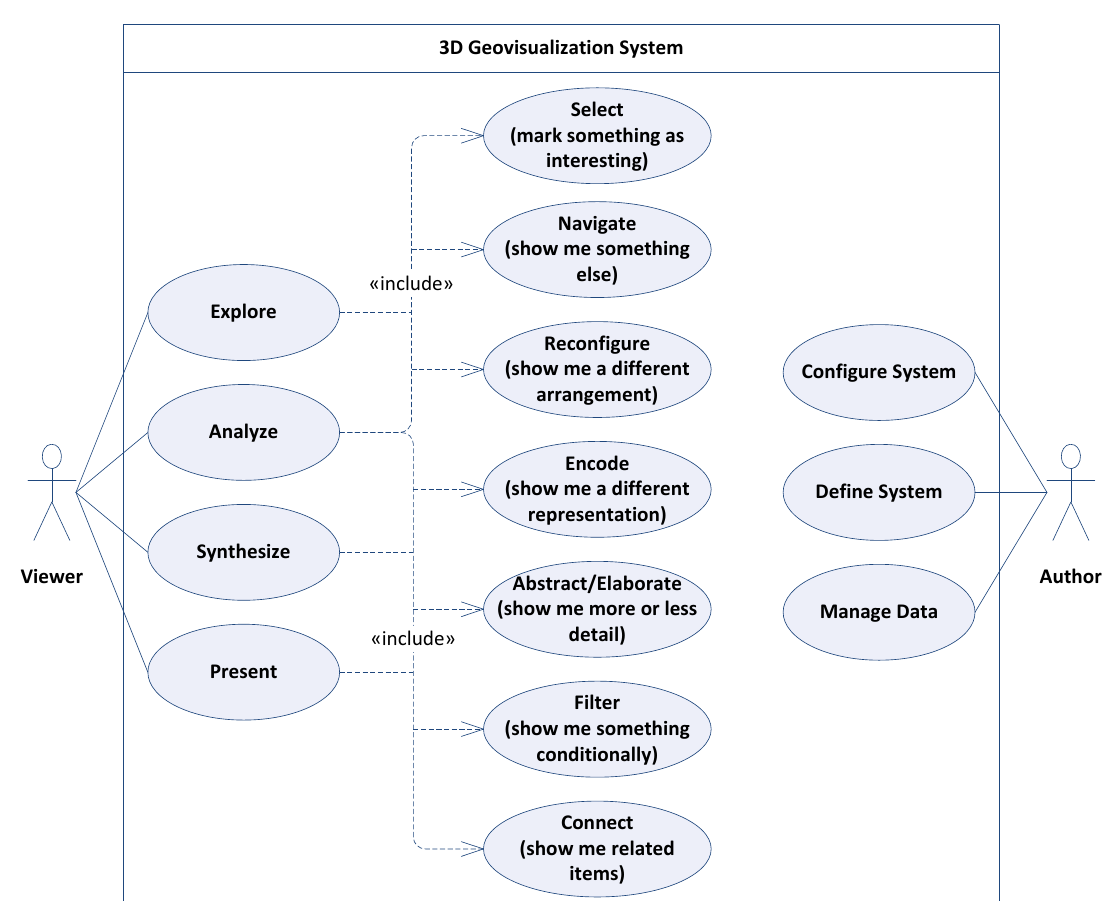
Figure 2. Use cases of a 3D geovisualization system (3DGeoVS) with user roles, viewer and